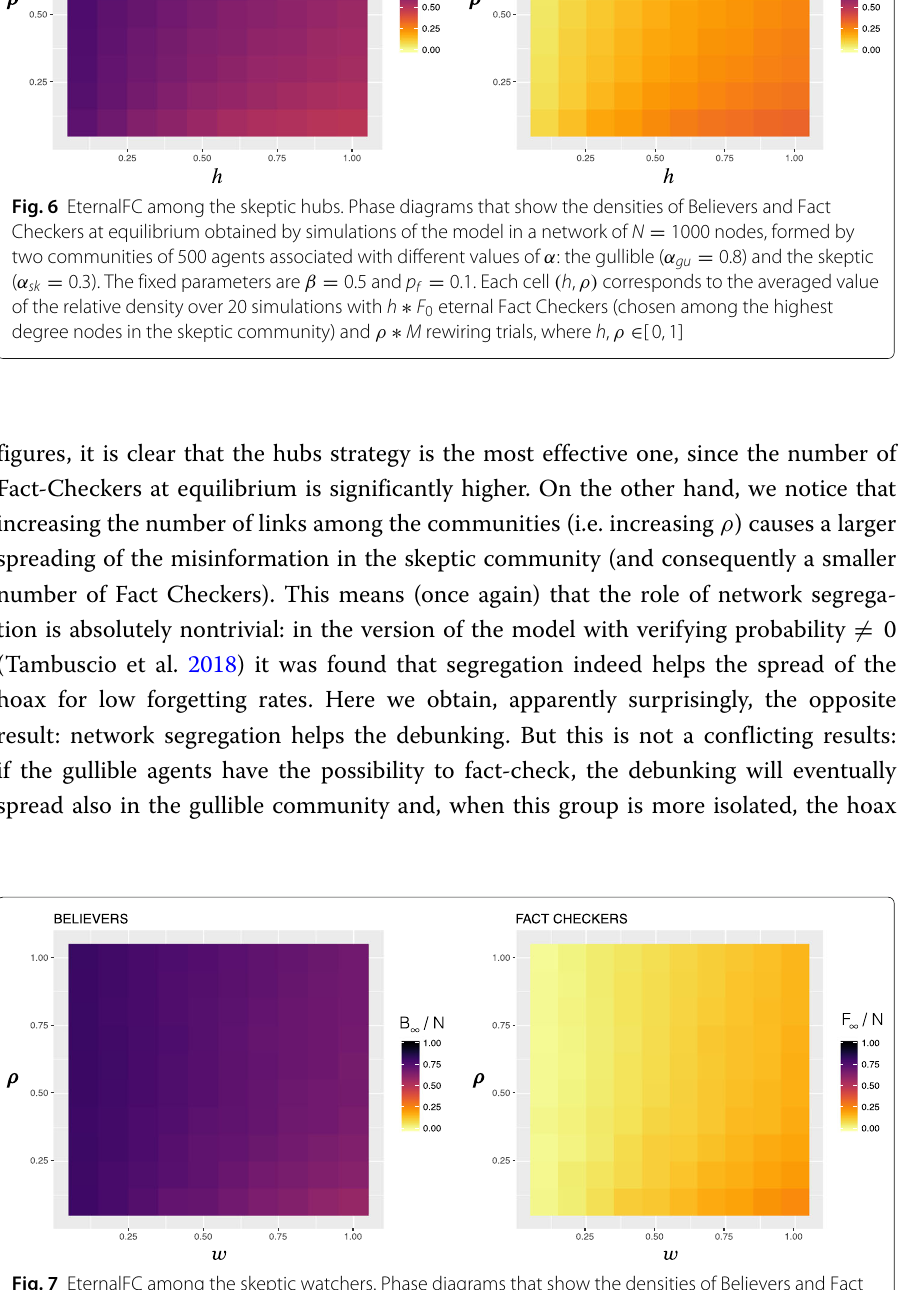
Fig. 7 EternalFC among the skeptic watchers. Phase diagrams that show the densities of Believers and Fact Checkers at equilibrium obtained by simulations of the model in a network of N = 1000 nodes, formed by two communities of 500 agents associated with different values of α : the gullible ( α gu = 0.8) and the skeptic ( α sk = 0.3). The fixed parameters are β = 0.5 and p f = 0.1. Each cell ( w , ρ) corresponds to the averaged value of the relative density over 20 simulations with w ∗ F 0 eternal Fact Checkers (chosen among the skeptic nodes that are connected with gullible ones) and ρ ∗ M rewiring